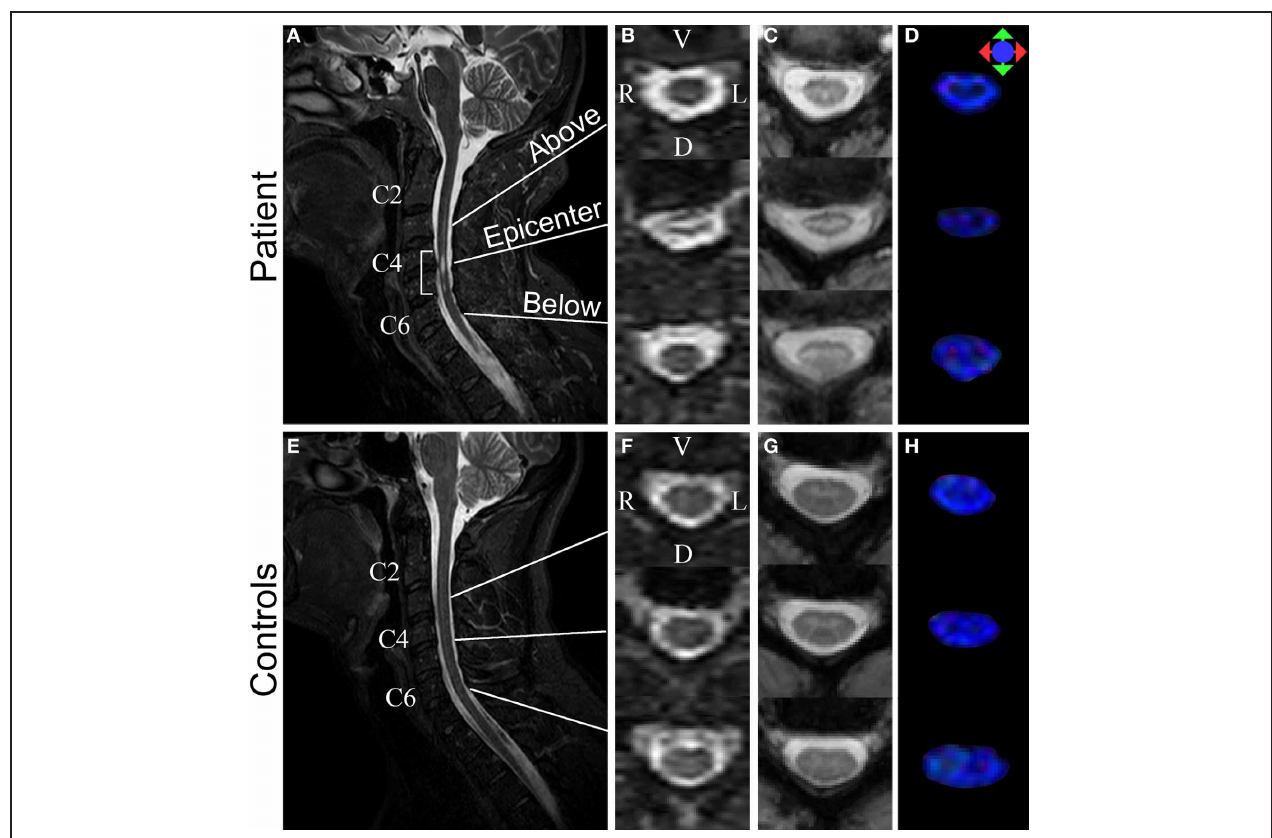
using a standard diffusion color-encoding scheme (r/l: red, a/p: green, s/i: blue). Each row of (B–D) shows a section from: (1) above the injury epicenter, (2) injury epicenter, and (3) below the injury epicenter. Images from the corresponding cervical levels in the control are shown in each row of (F–H)